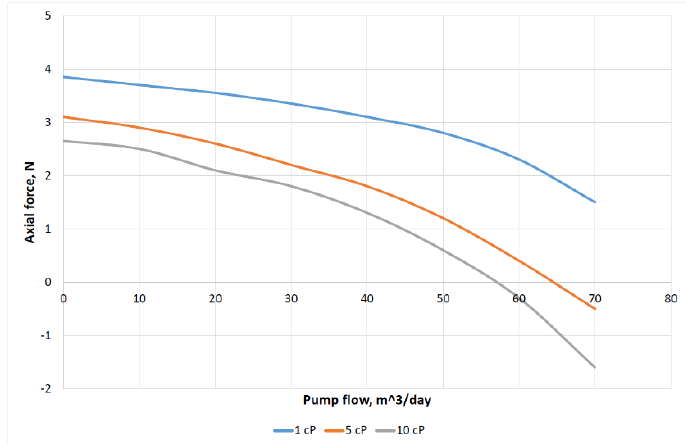
Figure 19. Interrelation between pump output and axial force acting on the open impeller at different viscosity values of the pumped liquid. Source: authors’ development.